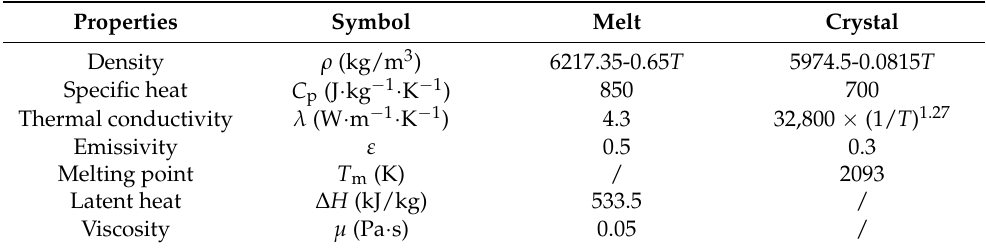
Table 1. Material properties of β -Ga 2 O 3 melt and crystal